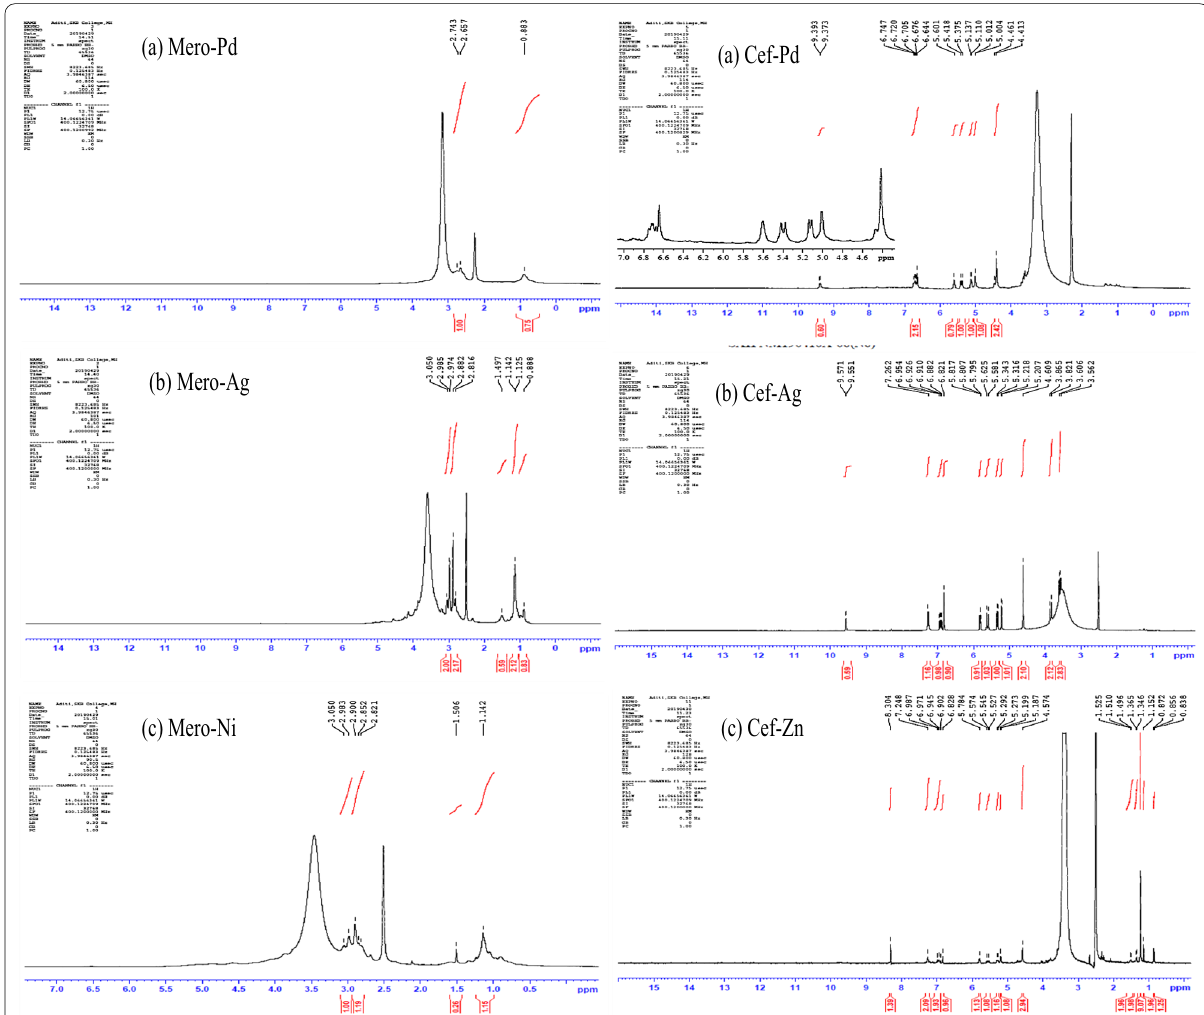
Fig. 5 NMR spectrum of a Mero-Pd, b Mero-Ag, c Mero-Ni and a Cef-Pd, b Cef-Ag, c